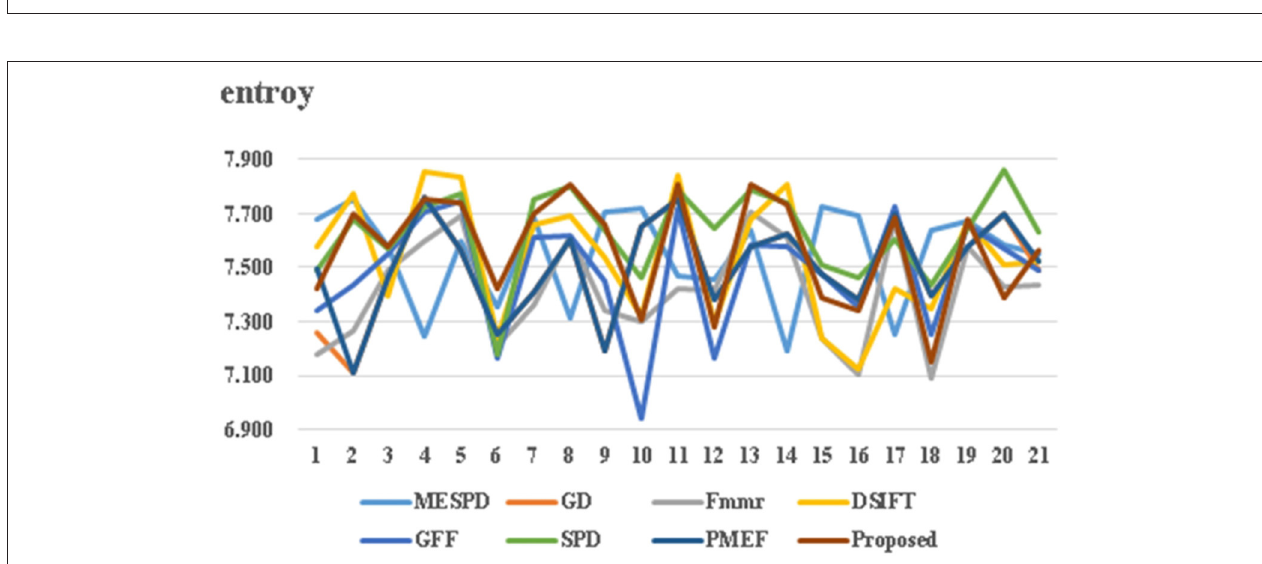
FIGURE 5 | Comparison of kluki scene experiment results of different methods.